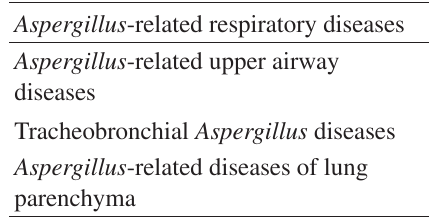
TABLE 1: Anatomical classification of Aspergillus -related respiratory